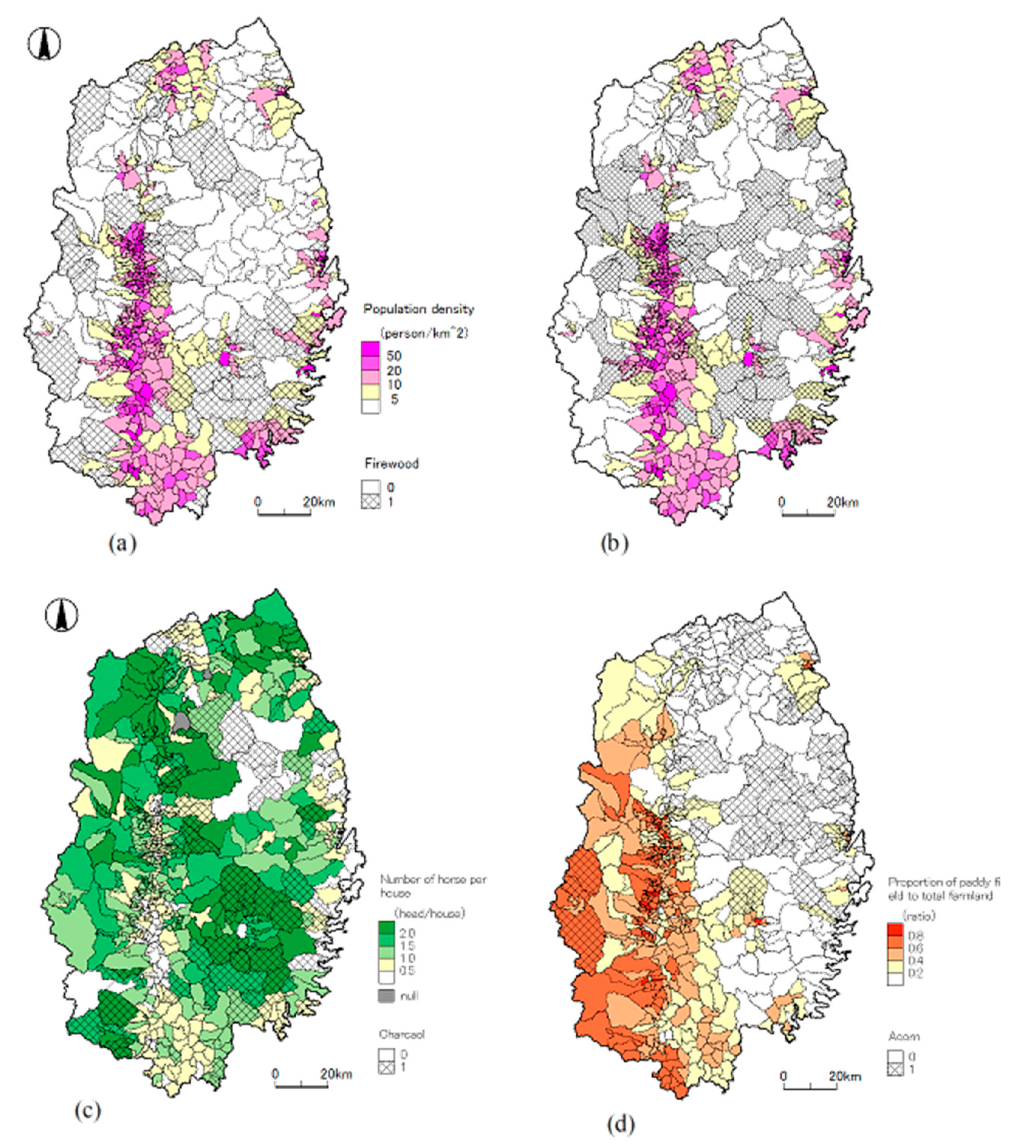
Figure 6. Map of each village in Iwate Prefecture showing the major forest products and village specifications from the 1970s to 1980s. ( a ) Population density and firewood production. ( b ) Population density and chestnut ( Castanea crenata ) production. ( c ) Number of horses per household and charcoal production. ( d ) Proportion of paddy fields to total farmland and acorn production. 1 in each product in the legend means “the production existed.”